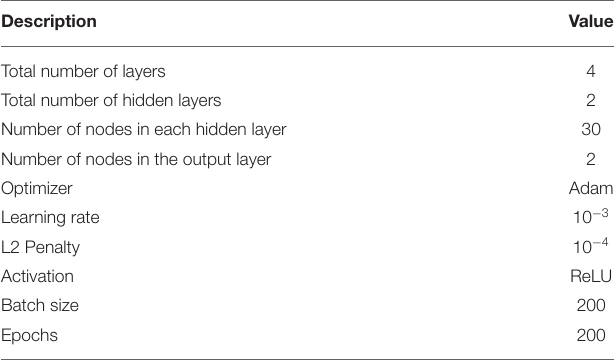
TABLE 8 | Parameters for neural network model trained using dataset of multilayer network. Description Value Total number of